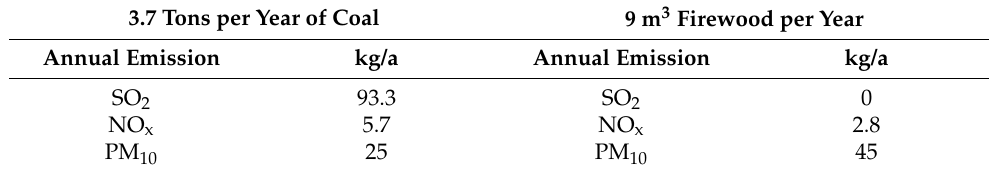
Table 14. Emissions from heating an uninsulated house on coal or firewood during 150 days in one year.